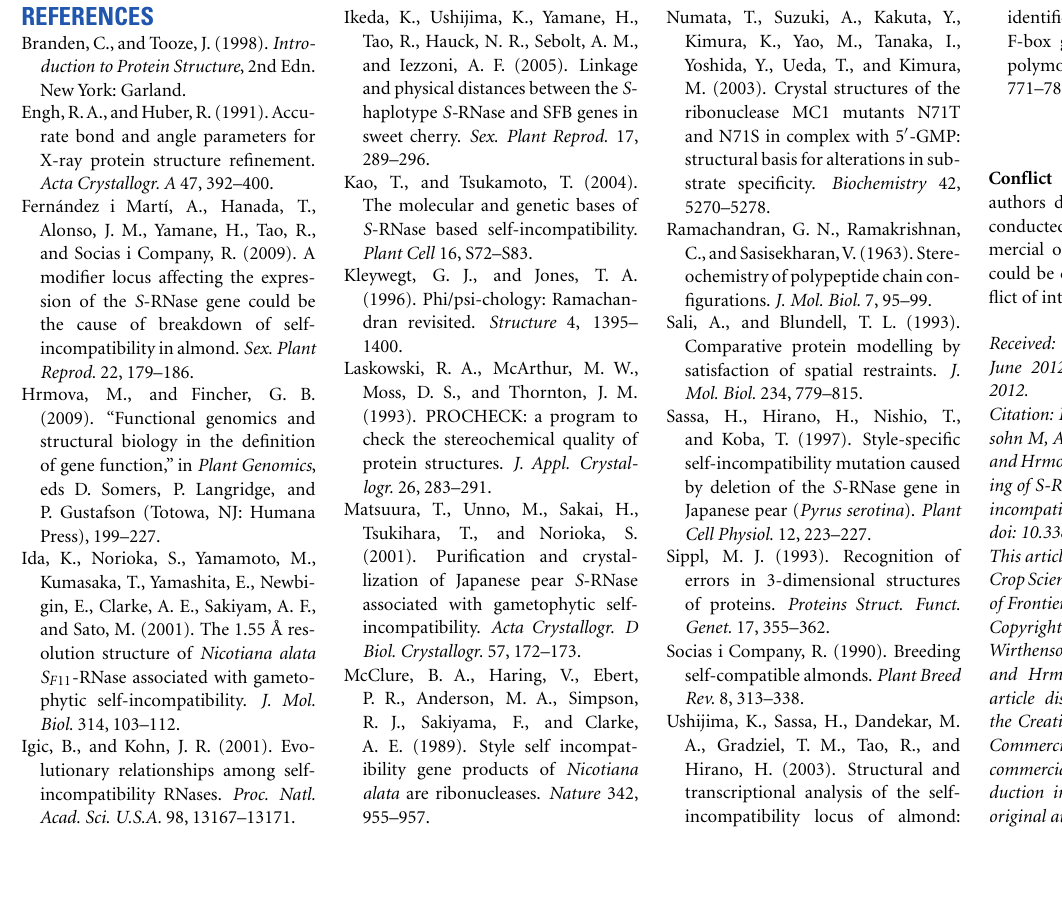
figurations. J. Mol. Biol. 7,95–99. Sali, A., and Blundell, T. L. (1993). Comparative protein modelling by satisfaction of spatial restraints.